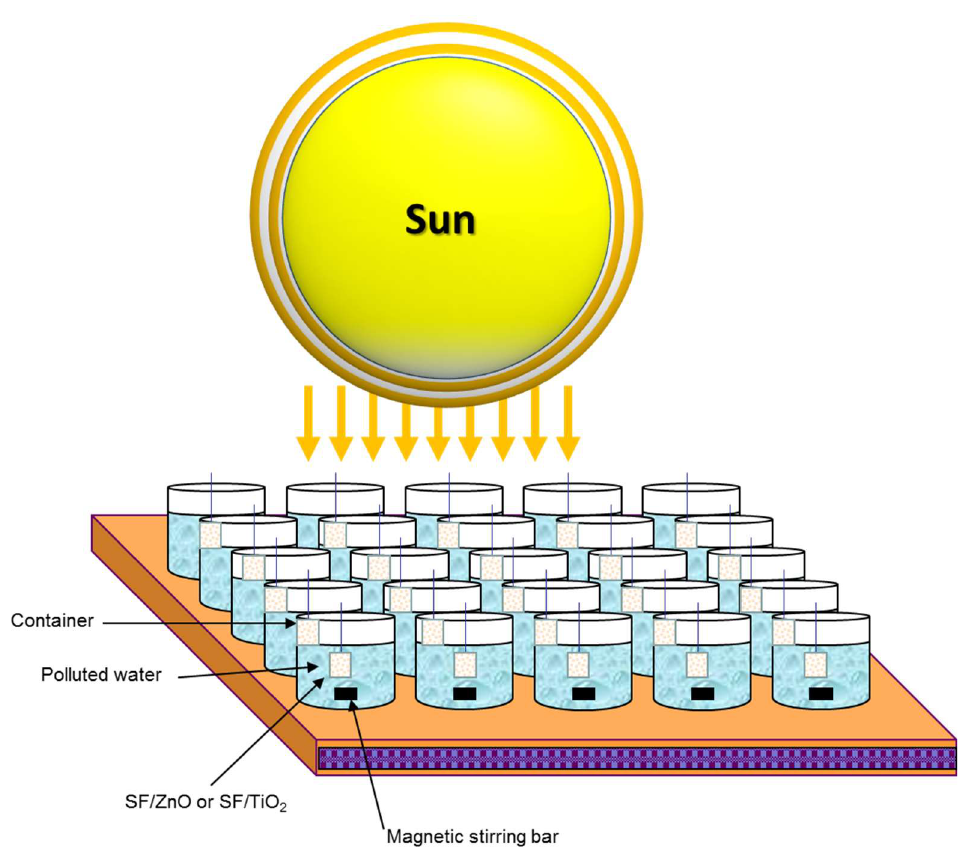
Figure 7. Schematic drawing of the experimental setup.